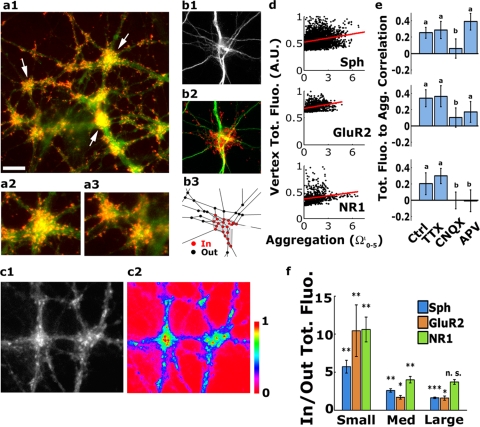
Activity-promoted synaptic clustering at DCCs.In all images (except c1 and c2), green = dendrites - anti-MAP2 antibody-staining; red = axonal varicosities - anti-synaptophysin antibody staining. (a1) Synaptophysin puncta aggregates (arrows) at DCCs. Note that the overall clumped synaptic organization in the field follows the DCC distribution. (a2) and (a3) Enlarged examples of DCCs and varicosity clusters, respectively, taken from (a1). (b1–b3) A representative field of the type used for quantitative analysis, where single dendritic processes (b1) and varicosities (b2) are clearly identified, and can be located within (‘In’) and out (‘Out’) of a DC cluster (red, silhouette value 0.751). (c1) Staining with anti-PSD-95 shows enrichment of postsynaptic densities at convergence sites. (c2) Color coding of c1 (scale bar: 0 = no fluorescence, 1 = maximal fluorescence). PSD-95 spots of the highest intensities are located at convergence sites. (d) A significant positive correlation between vertex-relative neighborhood density (Ω0–5) and vertex total fluorescence (see text for details) for both the presynaptic marker synaptophysin, and the postsynaptic markers, GluR2 and NR1 (0.25±0.03, 0.34±0.05 and 0.20±0.06 Pearson's correlation coefficient±95% C.I., n = 3130, 1113 and 789 vertices from 12, 4 and 4 fields for Sph, GluR2 and NR1, respectively). (e) CNQX abolished this correlation for all the markers; APV had a similar effect on NR1 distribution. (f) Quantification of the ratio (Inside/Outside DCCs) between the average intensity (total fluorescence (A.U.)/area) of the three synaptic markers. The synaptophysin density is always higher inside DCCs (p<0.01, 0.01 and 0.001 by the Wilcoxon rank test for the small, medium and large classes, respectively; n = 42,45 and 47 DCCs from 12 fields each, respectively). The distribution of post-synaptic GluR2 subunits of the AMPA receptor is also clumped around the three DCC classes (p<0.01, 0.05 and 0.05 by the Wilcoxon rank test for the small, medium and large classes, respectively; n = 10,17 and 18 DCCs from 4 fields each, respectively). The NR1 subunit of the NMDA receptor is clustered around small and medium but not near large DCCs (p<0.01 and 0.01 but p>0.05 by the Wilcoxon rank test for the small, medium and large classes, respectively; n = 9,9 and 12 DCCs from 4 fields each, respectively). .Scale bar: (a1) 20 µm, (a2–3) 15 µm and (b, c)10 µm.